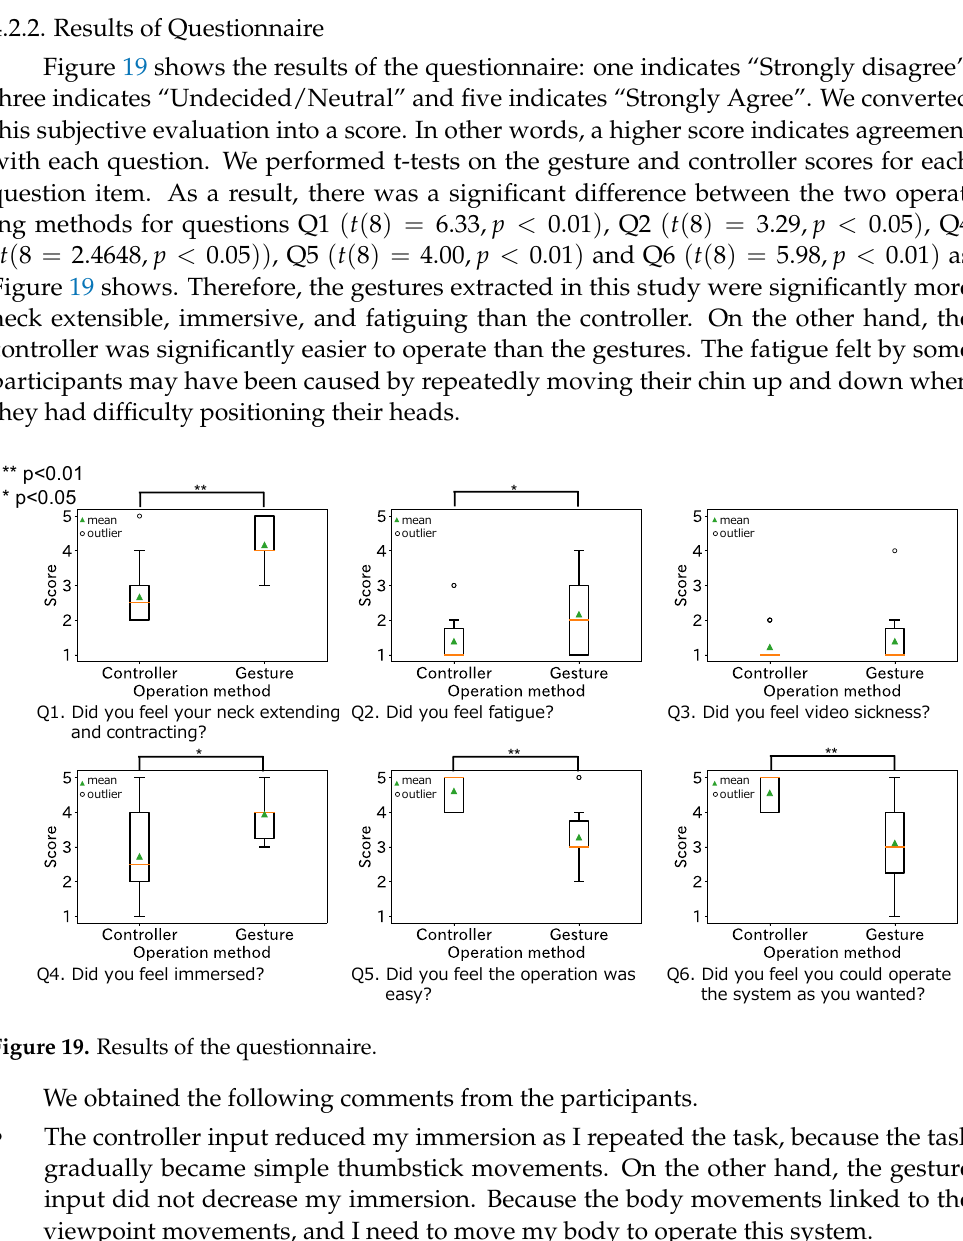
Figure 18. Transition of head position for each operation method during the task.